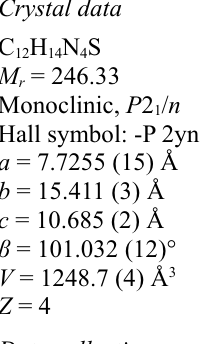
Figure 2 A diagram showing π - π stacking between aromatic rings [symmetry code: (ii) 1 + x , y , z ]. ( E )-3-Ethyl-4-(2-methylbenzylideneamino)-1 H -1,2,4-triazole- 5(4 H